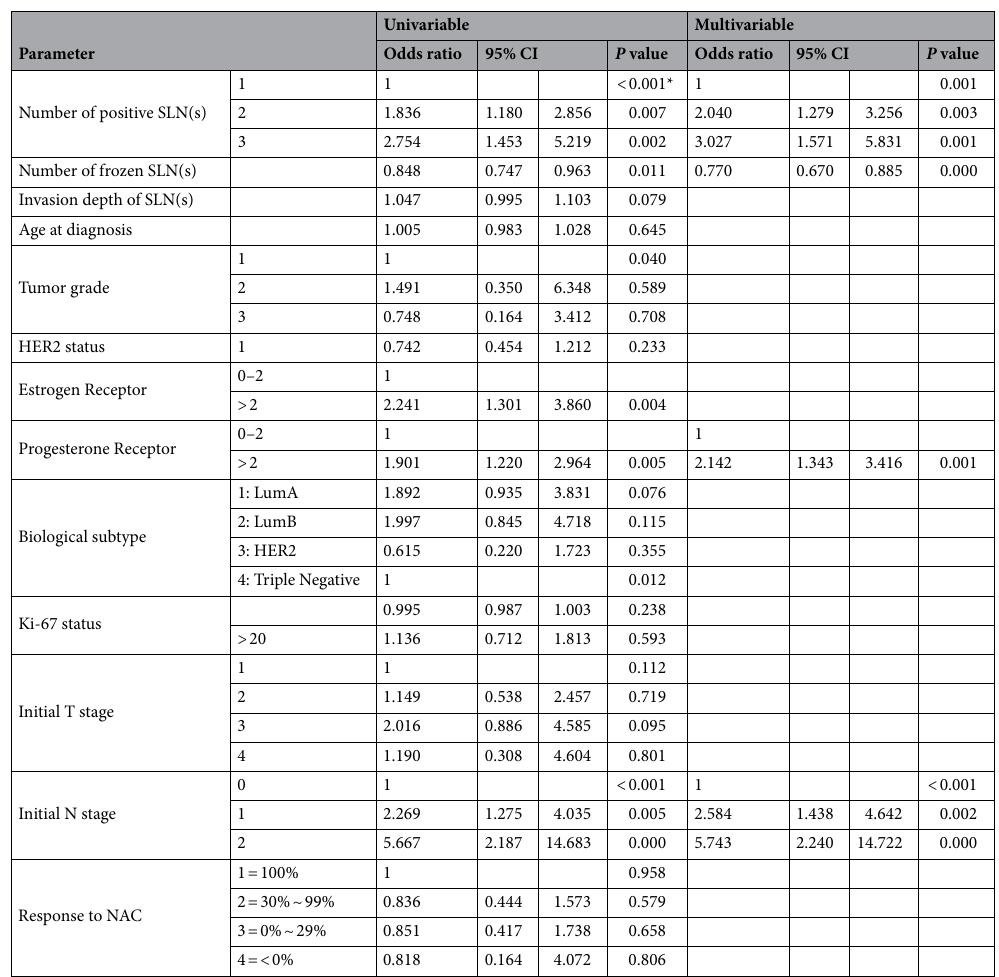
Table 3. Result of logistic regression for residual nodal disease. *The p -value written in the reference line means the overall p -value of the